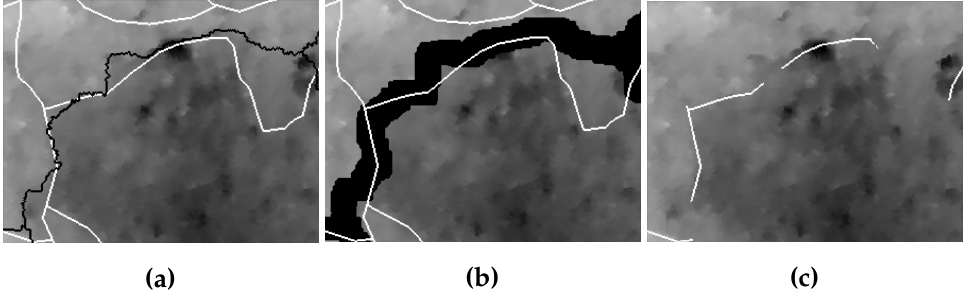
Figure 4. Example showing the interpretation of C B . The length of B r in the extent is 1775 px; the length of B m = 1185 px; the matched border length is 658 px, C B = 37%. ( a ) The CHM as the background layer; reference border B r marked with white line, segmentation border B m with black. ( b ) Segmentation border B m , dilated with a square structuring element. ( c ) B r AND B of the microstand border selected by the image analyst which are located close to the microstand border marked by the data processing workflow.